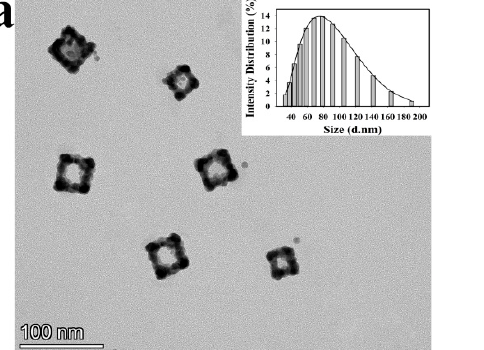
Figure 1. TEM image ( a ) and absorption spectrum ( b ) of GNCs. Insets are the DLS results and GNCs solution in ambient light, respectively. solution in ambient light,